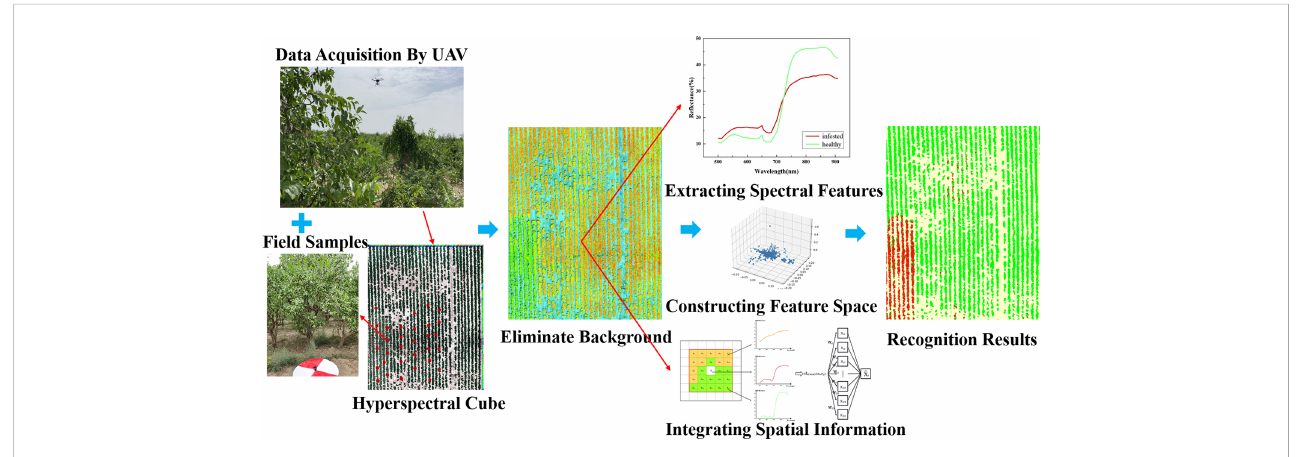
FIGURE 3 Framework of recognition program of jujube spider mite infestations.